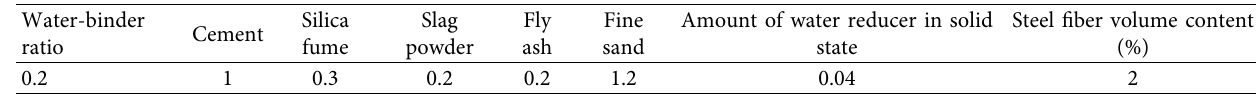
Figure 1: Dimensions and details of two example specimens. (a) PRPCB1 and (b) UPRPCB1. Table 2: Mix ratio of RPC.